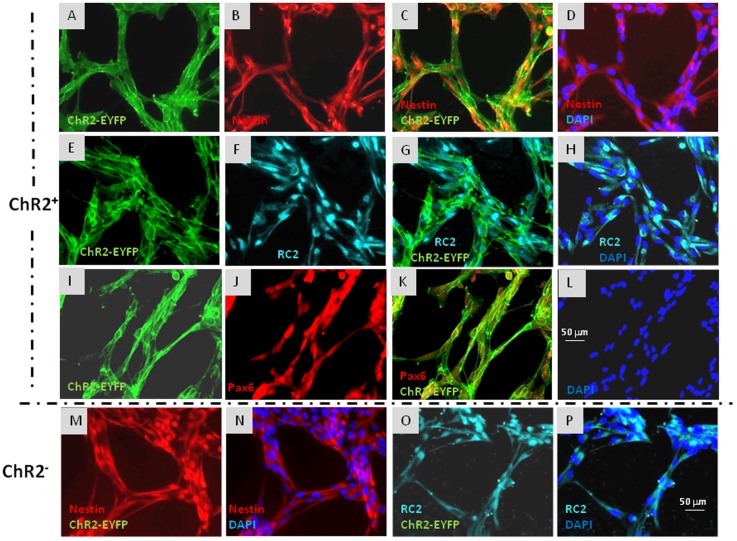
Immunocytochemical characterization of ChR2-eYFP expressing and non-expressing RGl cells. ChR2-eYFP expressing RGl cells were identified by eYFP fluorescence (A,C,E,G,I,K: green). Both ChR2+ (A–L) and ChR2- cells (M–P) displayed radial glial markers as nestin (B–D,M,N: red), RC2 (F–H,O,P: greenish blue) and Pax6 (J,K: red). Blue color shows DAPI staining of cell nuclei. All pictures were taken at the same magnification. Scale bars are presented on (L,P).